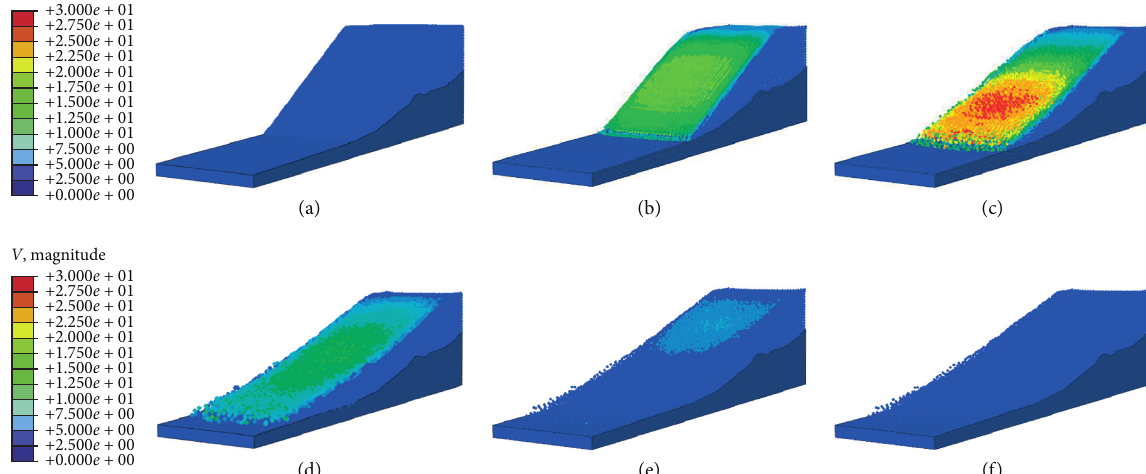
Figure 13: The velocity (Vmagnitude) and shapes of the landslides at different times. (a) t � 0s. (b) t � 8 s. (c) t � 17s. (d) t � 30s. (e) t � 40s. (f) t � 100s.